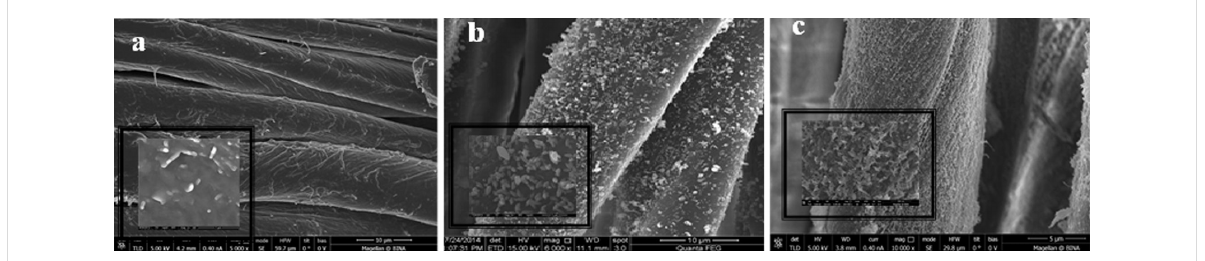
Figure 4: HRSEM images of (a) RB5 sonochemically deposited on cotton, (b) ZnO coated in the presence of RB5, (c) CuO coated in the presence of RB5; insets were taken in higher magnification.